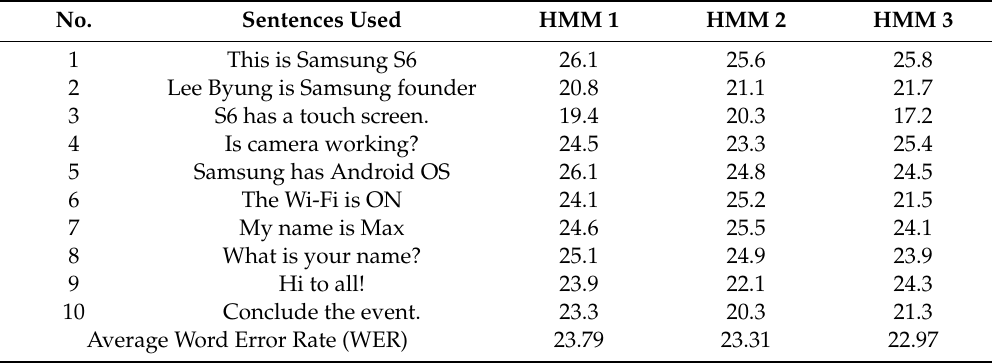
Table 3. Word Error Rate of the three Hidden Markov Model (HMM)-based